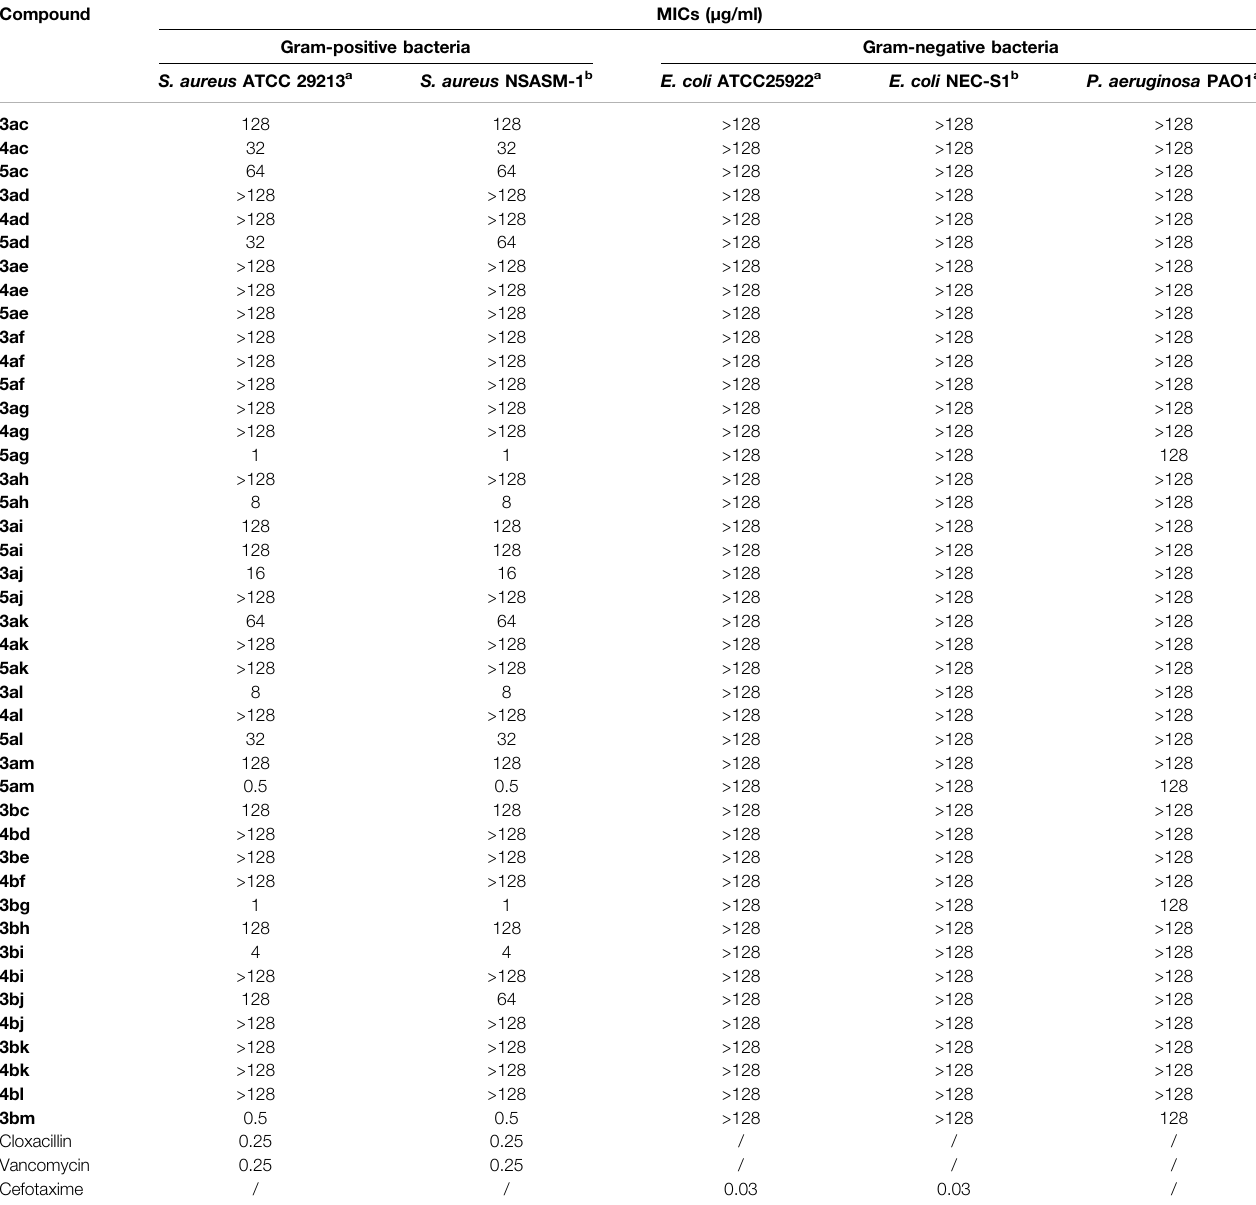
TABLE 3 | MIC values ( μ g/ml) of the tested compounds against the Gram-positive and Gram-negative pathogen panel. Compound MICs ( μ